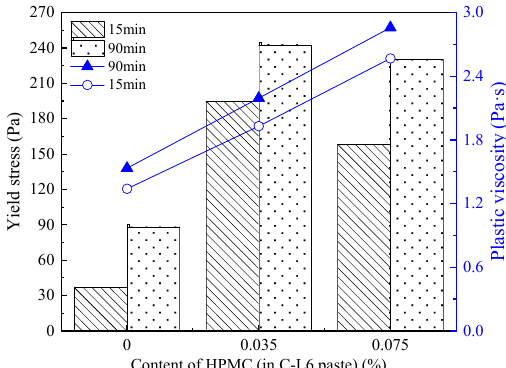
Figure 17. Yield stress and plastic viscosity of C-L6-HPMC pastes.